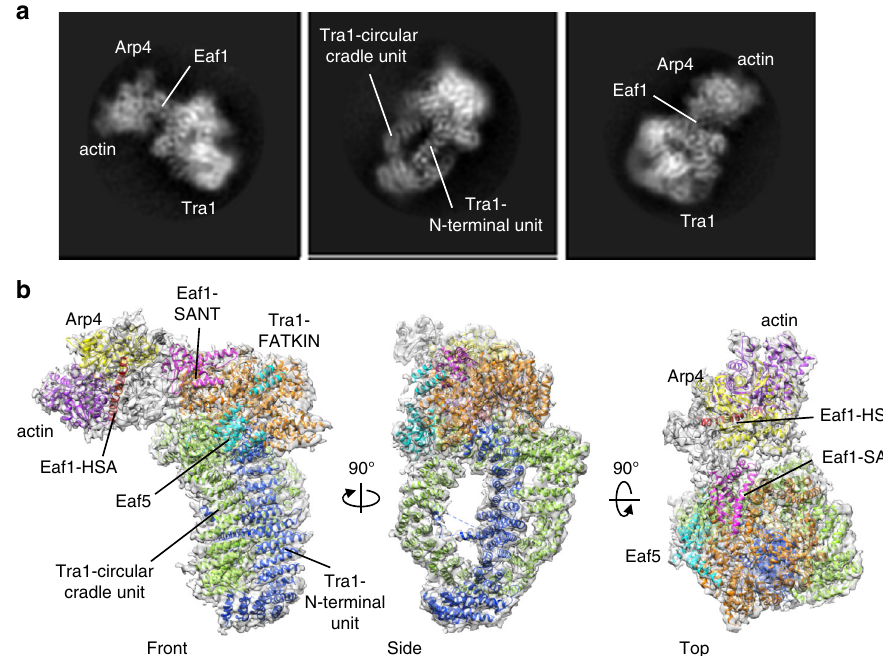
Fig. 2 Architecture of the NuA4 TEEAA assembly. a Three representative 2D class averages of the NuA4 TEEAA. b Three views of the NuA4 TEEAA assembly. The cryo-EM density map is shown as a translucent surface and fi tted with the ribbon diagram model. Arp4 is in yellow, actin in purple, and Eaf5 in cyan. The Tra1 FATKIN is shown in orange and the N-terminal HEAT repeats are colored in blue (N-terminal unit) and in light green (circular cradle unit). The Eaf1 is colored in red (HSA domain), in magenta (SANT domain), and in gray (other regions). Each successive view is rotated as